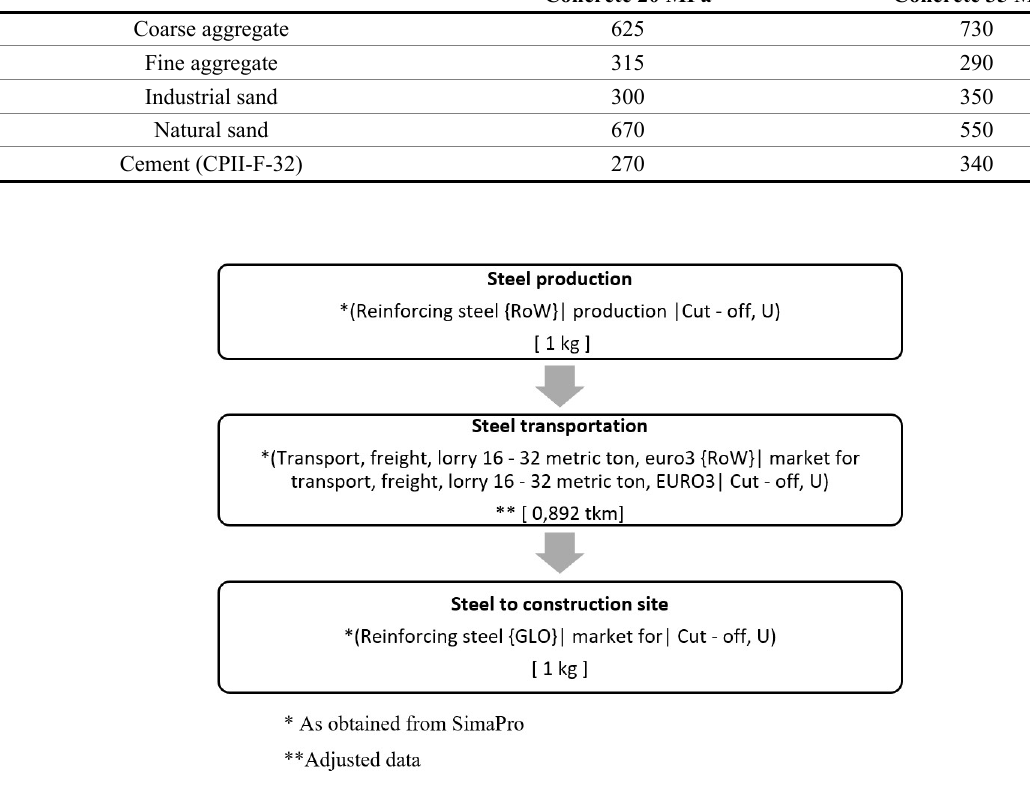
Figure 1. Flowchart with adjusted data for steel